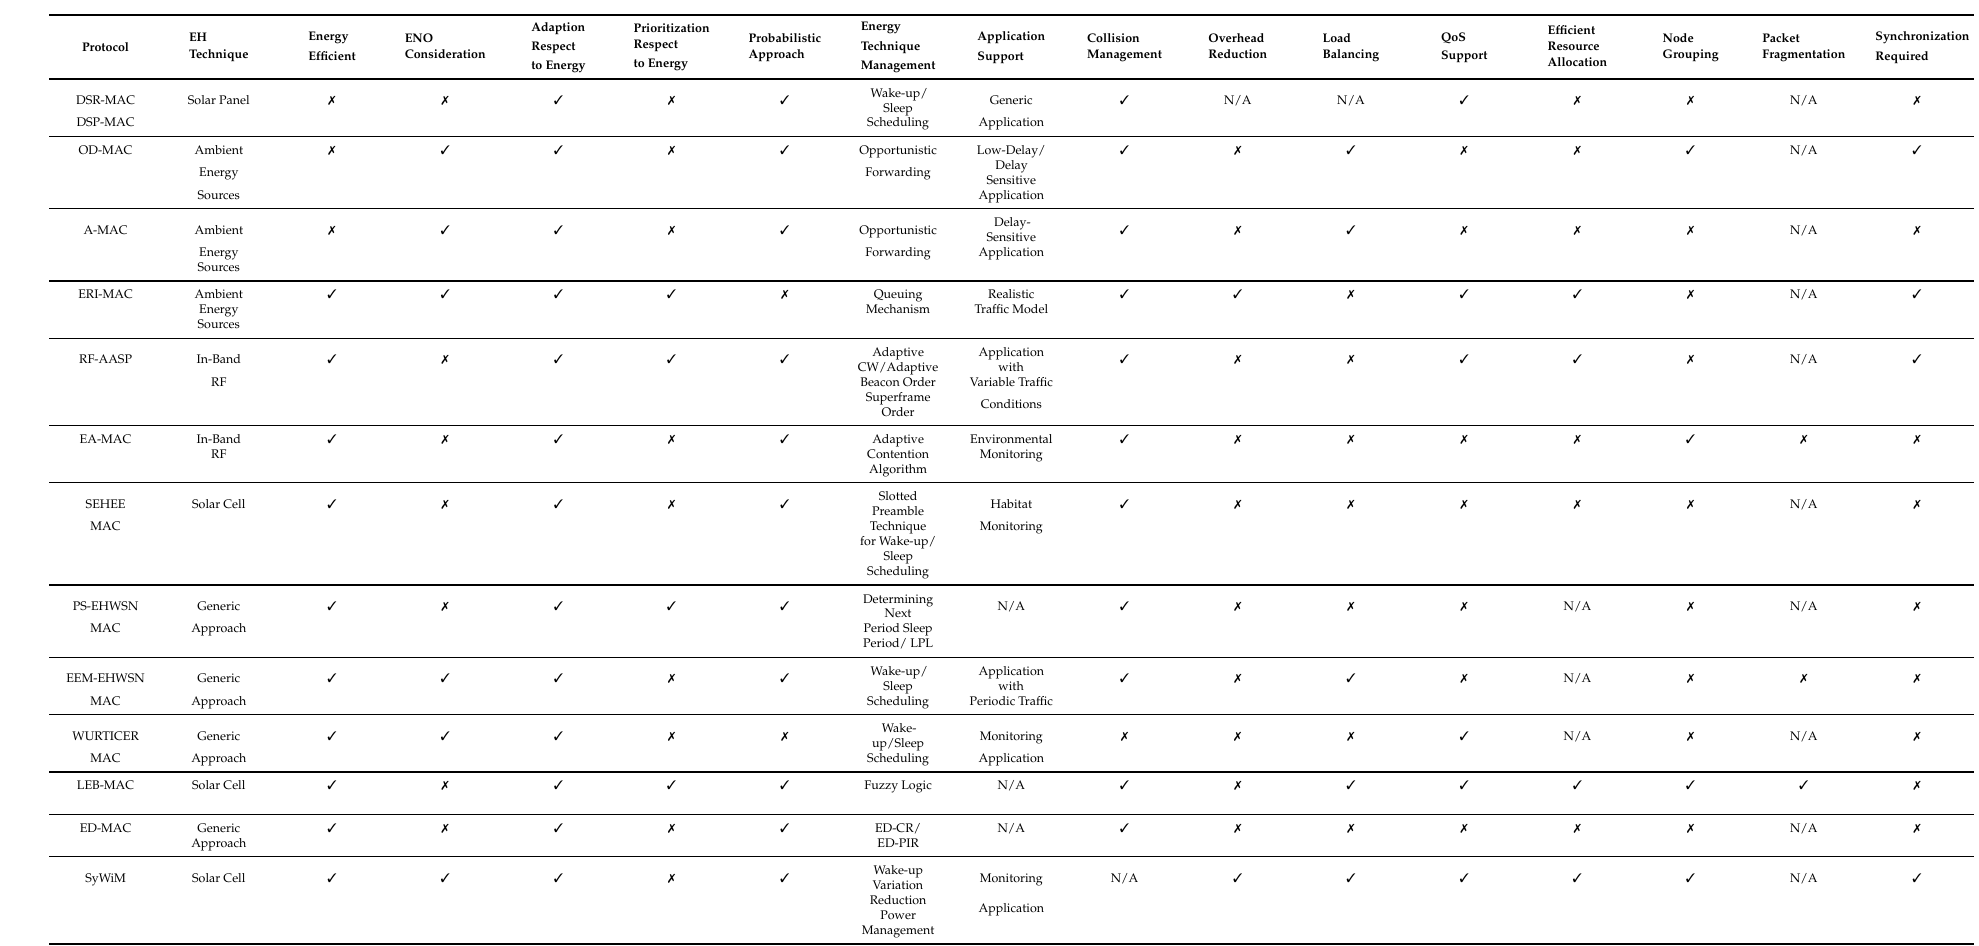
Protocol Overhead Reduction